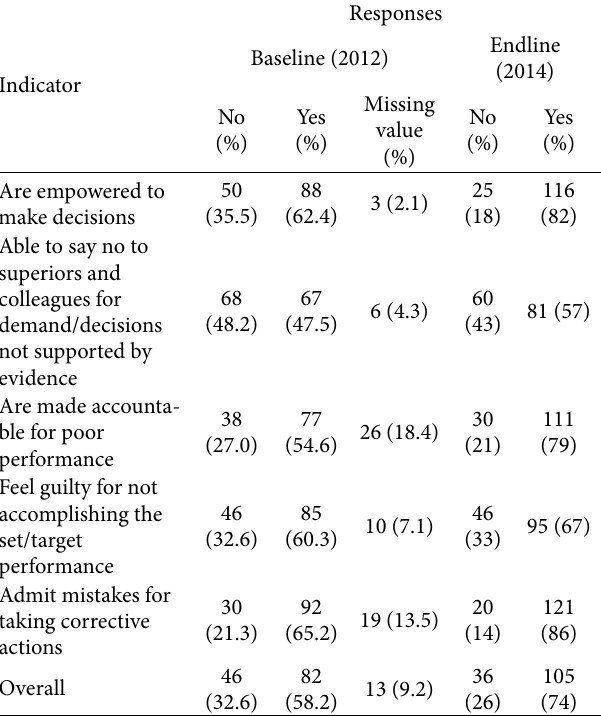
Table 6: Promotion of